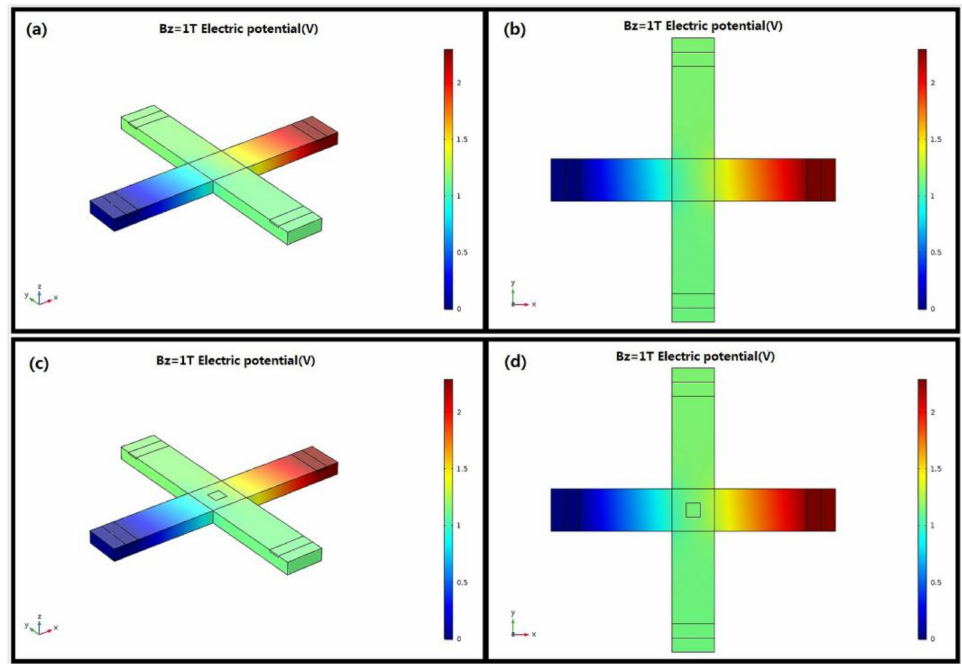
Figure 11. Voltage distribution of the horizontal and cross-shaped 3D Hall devices in 3D space and in the x , y plane. ( a , b ) Horizontal Hall device. ( c , d ) Cross-shaped 3D Hall